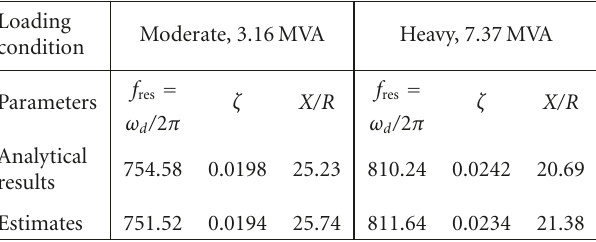
Table 4: Estimation results when load power factor is 0.87.